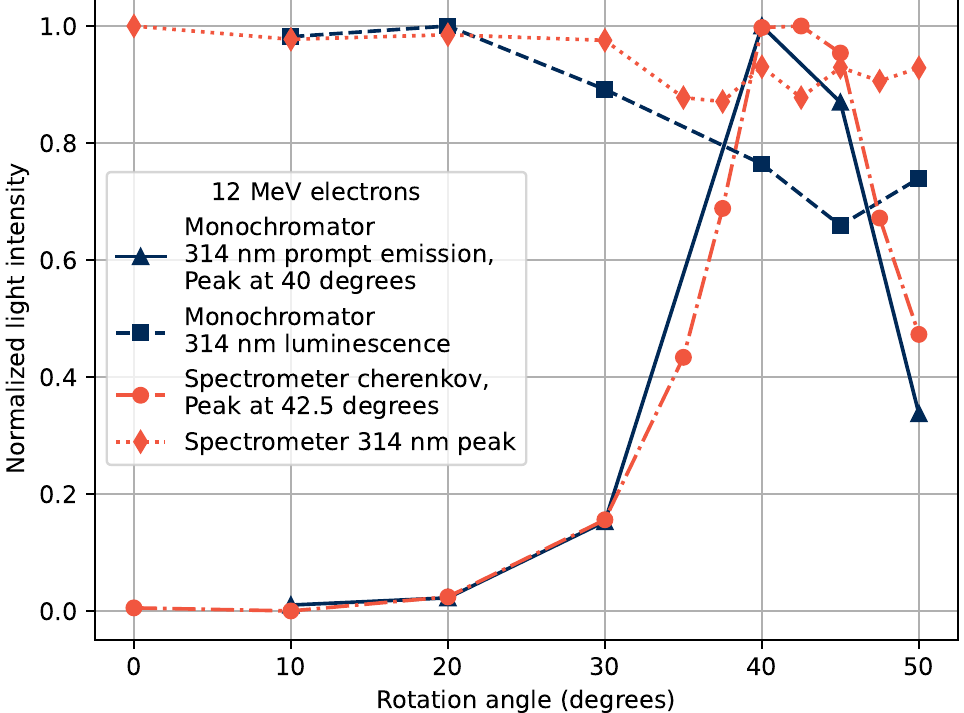
Figure 7. Detected light intensity as a function of the beam tilting angle of a 12 MeV electron beam obtained with digitized PMT signal and monochromator set to 314 nm shown in blue, and with optical spectrometer shown in